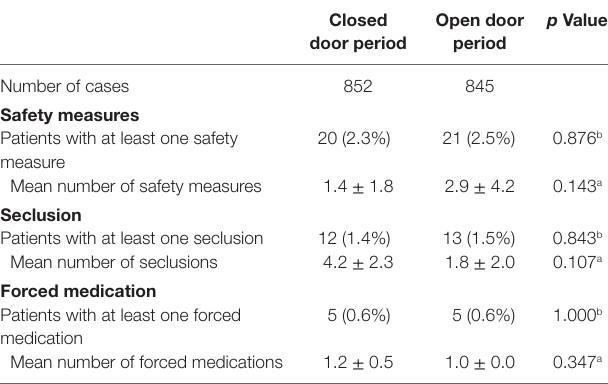
TaBle 4 | Safety measures before and after the introduction of predominantly open doors on all wards except the